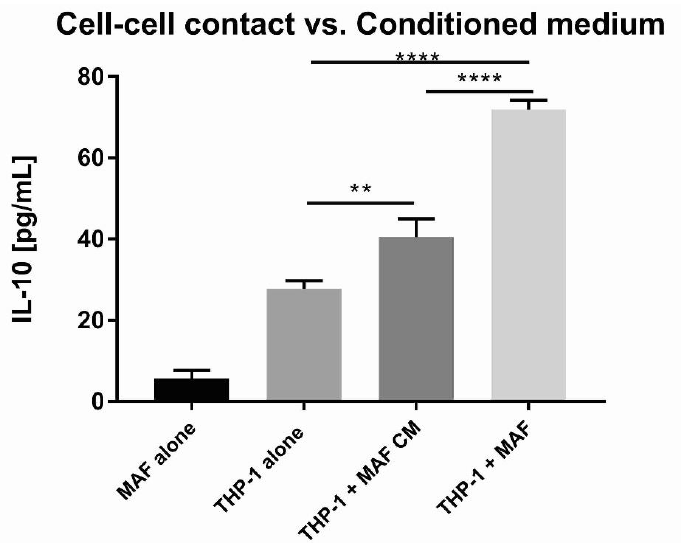
Figure 9. IL-10 concentration in supernatants of MAF monoculture, THP-1 monoculture, MAF- derived conditioned media (MAF CM)-treated THP-1 monoculture, and MAF/THP-1 co-culture, n = 5. Error bars represent means ± s.e.m. ** p < 0.001 and **** p < 0.0001.